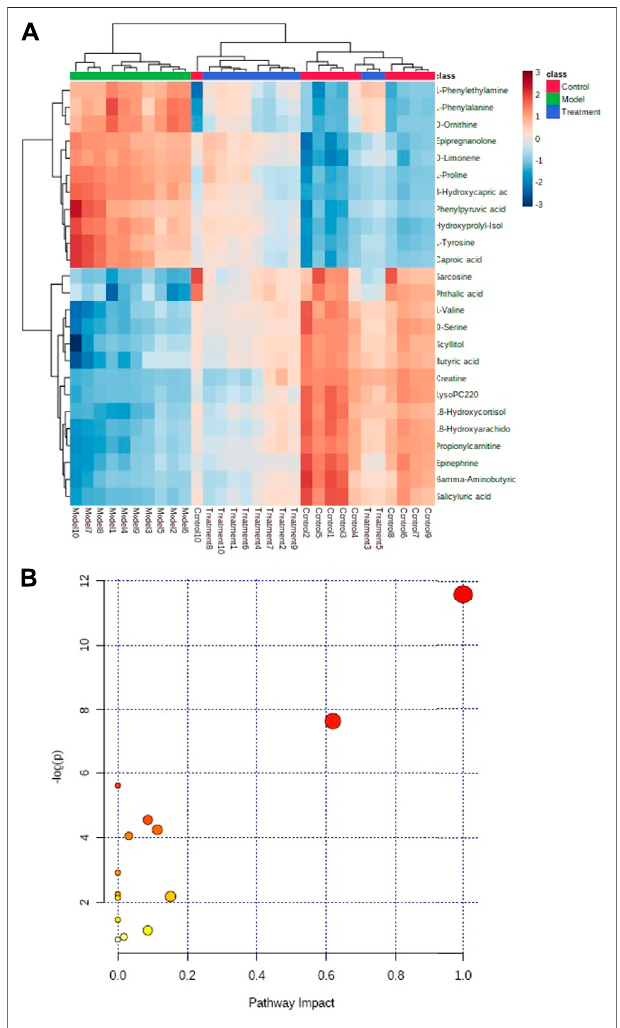
FIGURE 4 | Heatmap of potential metabolites in control group, model groupandtreatmentgroups (A) .Regulatorypathwayanalysisofmagno fl orine treatment (B)